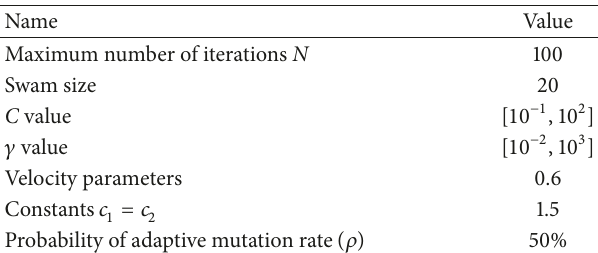
Table 2: The parameters of